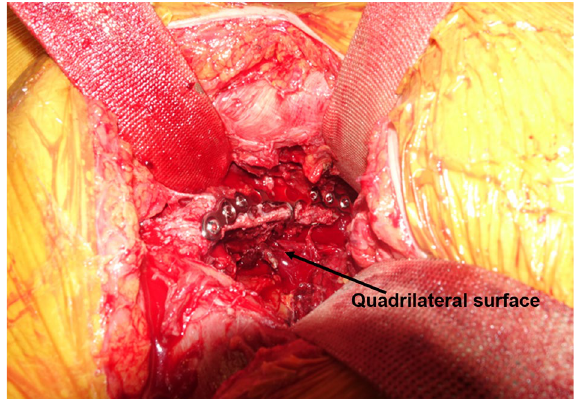
Figure 8. Intraoperative picture showing the excellent buttress effect of the plate for displaced quadrilateral